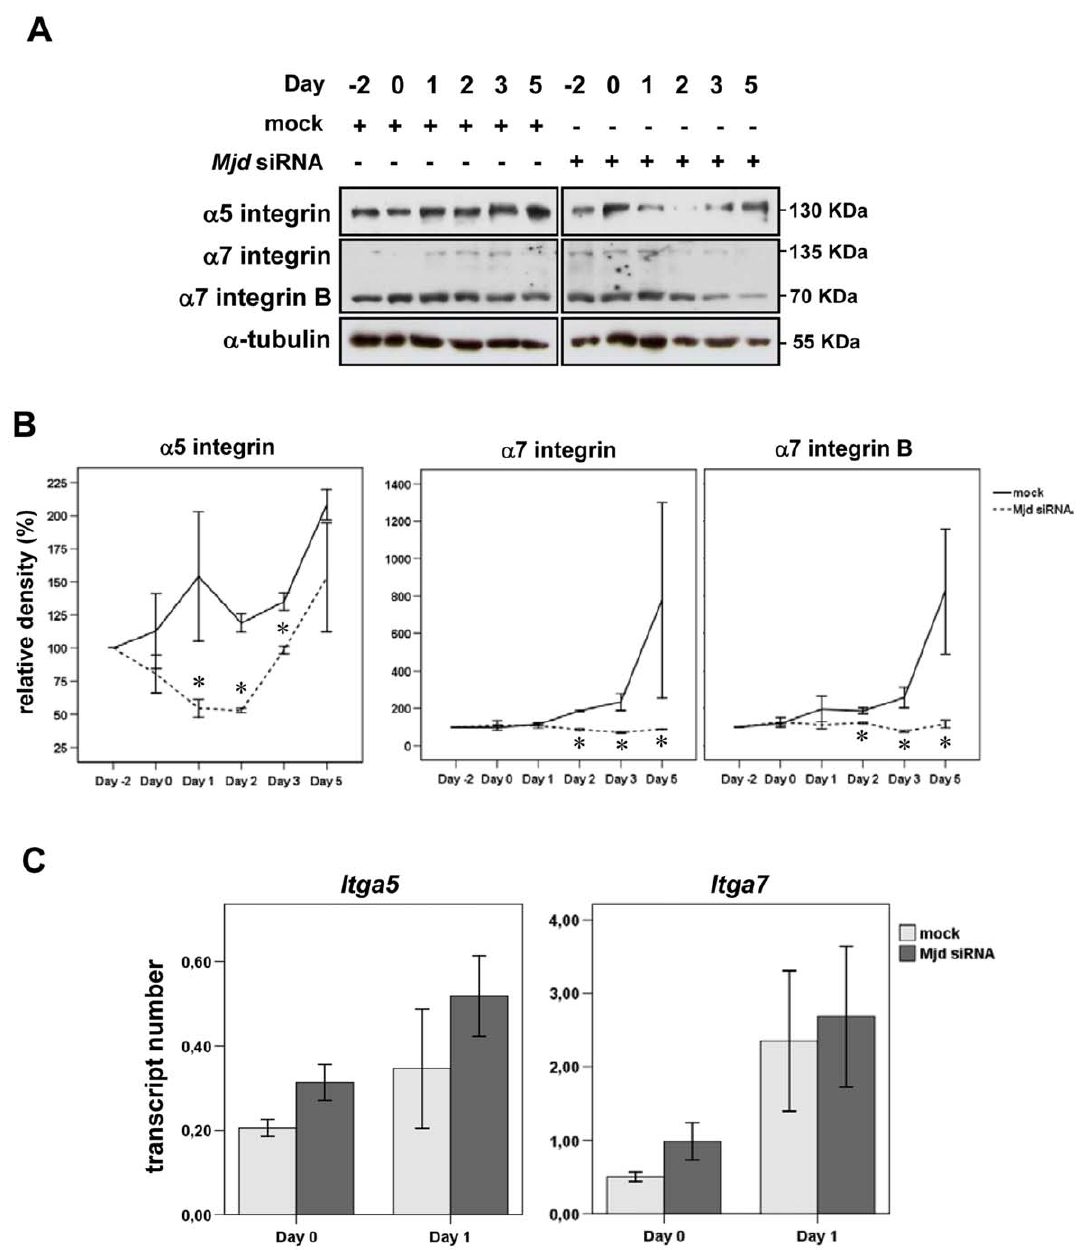
Figure 3. Ataxin-3 regulates the protein levels of a 5 and a 7 integrin subunits. (A) The amounts of a 5 and a 7 integrin subunits were determined by immunoblotting. Whole cell extracts of undifferentiated (Day -2 and Day 0) and differentiated cells (Day 1 to Day 5) were analyzed for a 5 and a 7 integrin subunits and a -tubulin in mock and Mjd siRNA transfected cells. (B) Relative band density of a 5 integrin, a 7 integrin (A + B) and a 7B integrin subunits in each day (comparing with Day -2), and for each transfection condition. The results were normalized for a -tubulin and correspond to the average of three independent transfections 6 SEM (error bars). (C) Ataxin-3 is not regulating the amounts of Itga5 and Itga7 transcripts. Mock and Mjd siRNA transfected C2C12 cells at Day 0 and Day 1 of differentiation, show identical transcript levels of Itga5 and Itga7 that were measured by real-time RT-PCR. The results were normalized for the Hprt1 gene and correspond to the mean of three independent transfections 6 SEM (error bars). * statistical significance p , 0.05 using Student t-test.